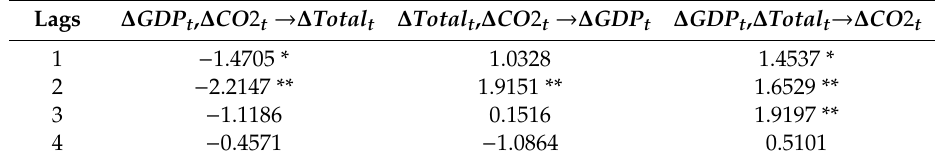
Table 9. Multivariate Nonlinear Granger Causality